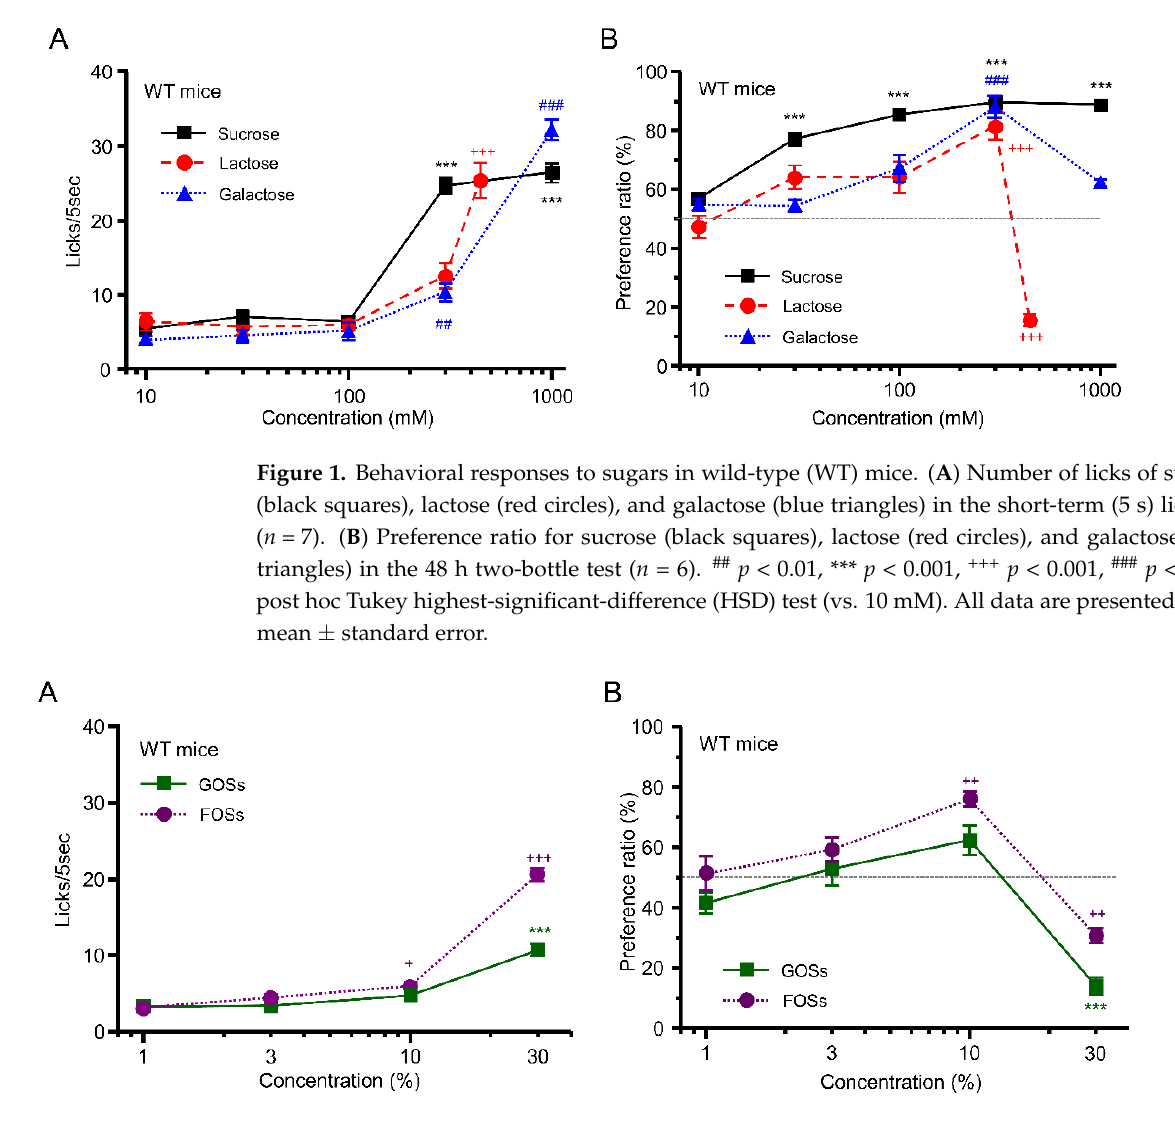
Figure 2. Behavioral responses to oligosaccharides in WT mice. ( A ) The number of licks of galacto- oligosaccharides (GOSs, green squares) and fructo-oligosaccharides (FOSs, purple circles) in the short-term (5 s) lick test ( n = 7). ( B ) Preference ratio for GOSs (green squares) and FOSs (purple circles) in the 48 h two-bottle test ( n = 6). + p < 0.05, ++ p < 0.01, *** p < 0.001, +++ p < 0.001, post hoc Tukey HSD test (vs. 1%). All data are presented as the mean ± standard error.